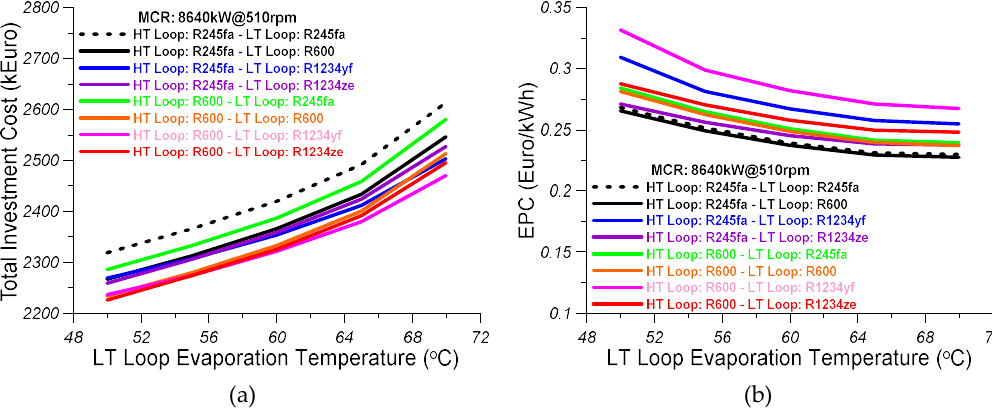
Figure 14. (a) Effect of the evaporation temperature of the LT loop on the total investment cost of the regenerative dual-loop ORC; (b) Effect of the evaporation temperature of the LT loop on the electricity production cost (EPC) of the regenerative dual-loop ORC. Results are given for all the pairs of organic mediums that are examined in the present study.